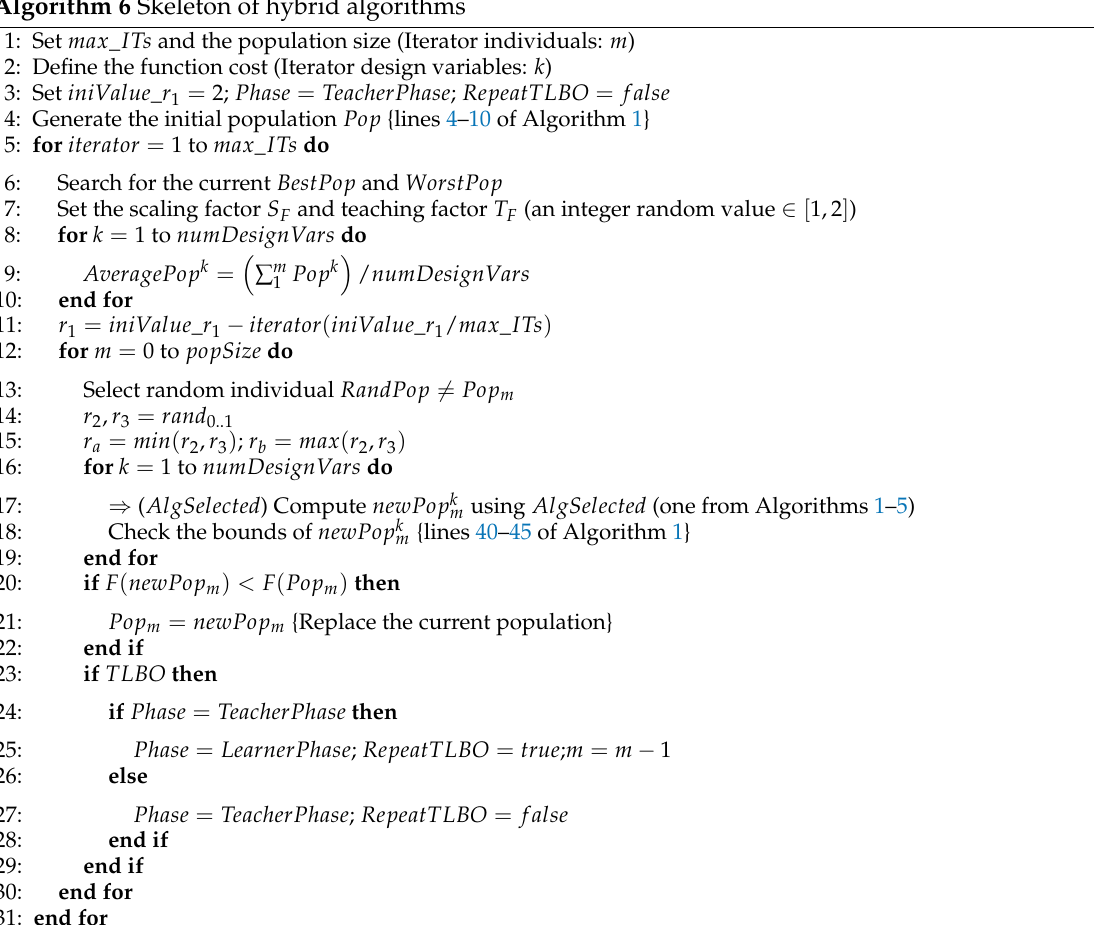
Algorithm 6 Skeleton of hybrid algorithms